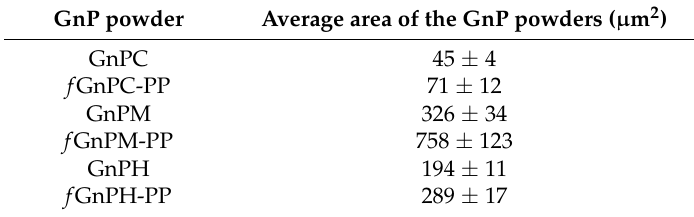
Table 2. Average area of the GnP primary nanoparticle agglomerates and significance within a 95% confidence